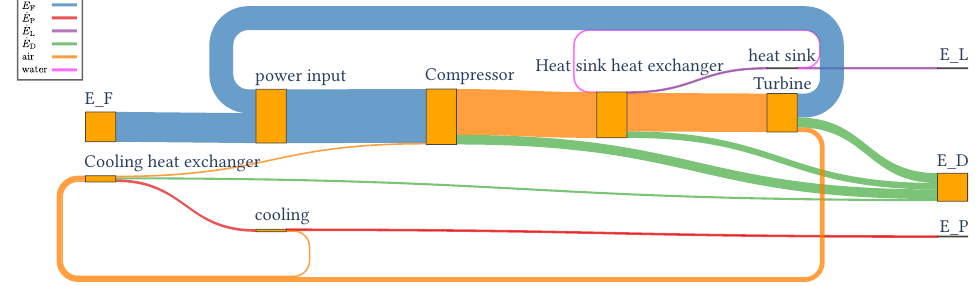
Figure 10. Machine-generated Grassmann diagram for the refrigeration cycle. The value of the exergy flows are shown in a true-to-scale manner by the width of the